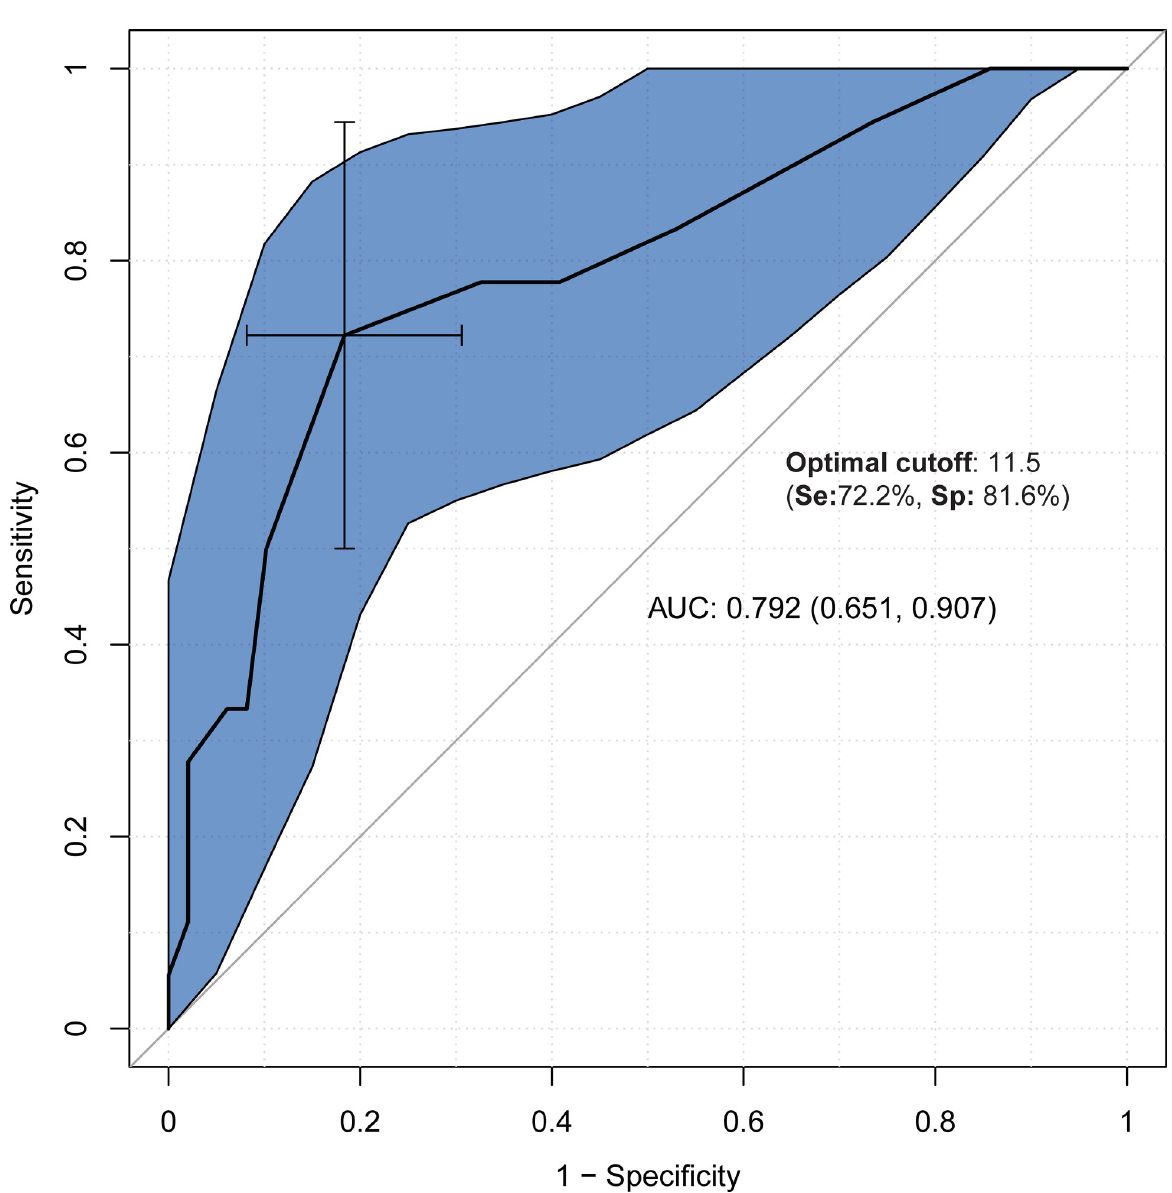
Fig 3. Discriminant power of the FAB-E among Parkinson’s disease patients with (MMSE < 24) and without (MMSE � 24) dementia. Abbreviations: Se, sensitivity; Sp, specificity; AUC, area under the curve.